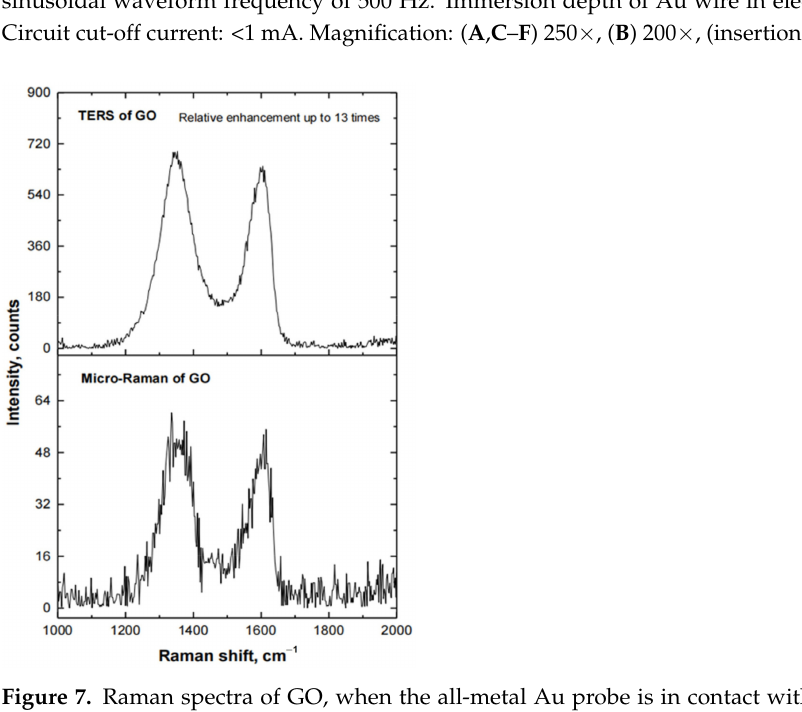
Figure 6. ( A – F ) SEM images of six all-metal Au probes, fabricated by electrochemical etching of Au micro-wire in 5 M NH 4 Cl aqueous solution at an alternating voltage from 1.0 to 4.5 V with a sinusoidal waveform frequency of 500 Hz. Immersion depth of Au wire in electrolyte: ~1.5 mm.